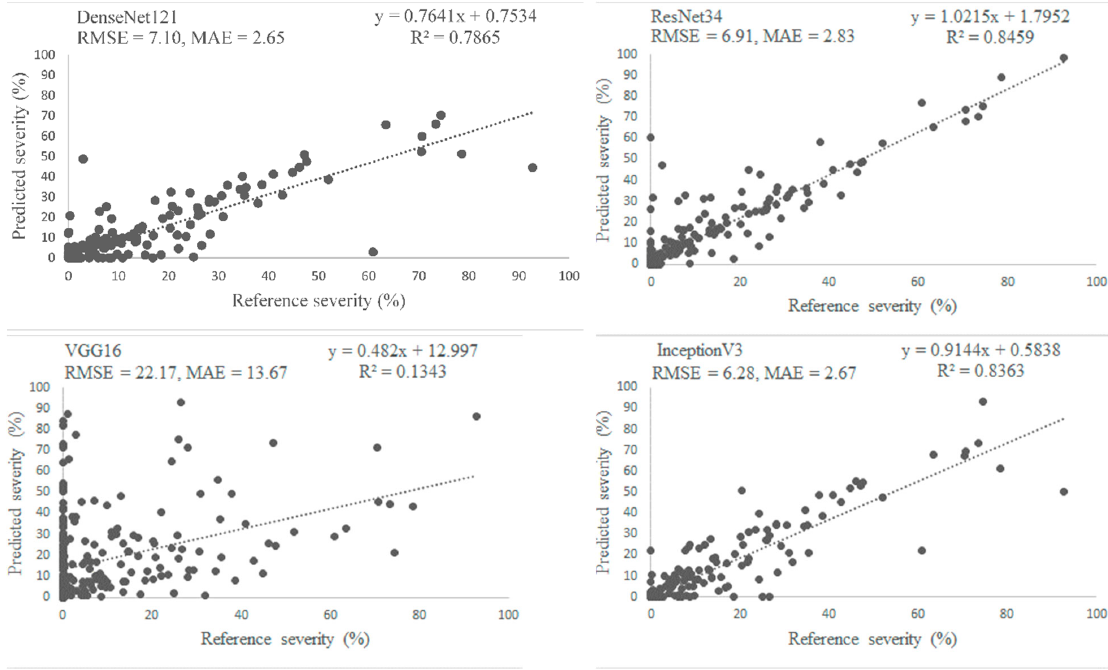
Figure 7. Scatter plots of the first ‐ order regression line for the relationship between reference severity obtained from reference masks (manually annotated) and the severity estimated by using the U ‐ Net model and different backbones.